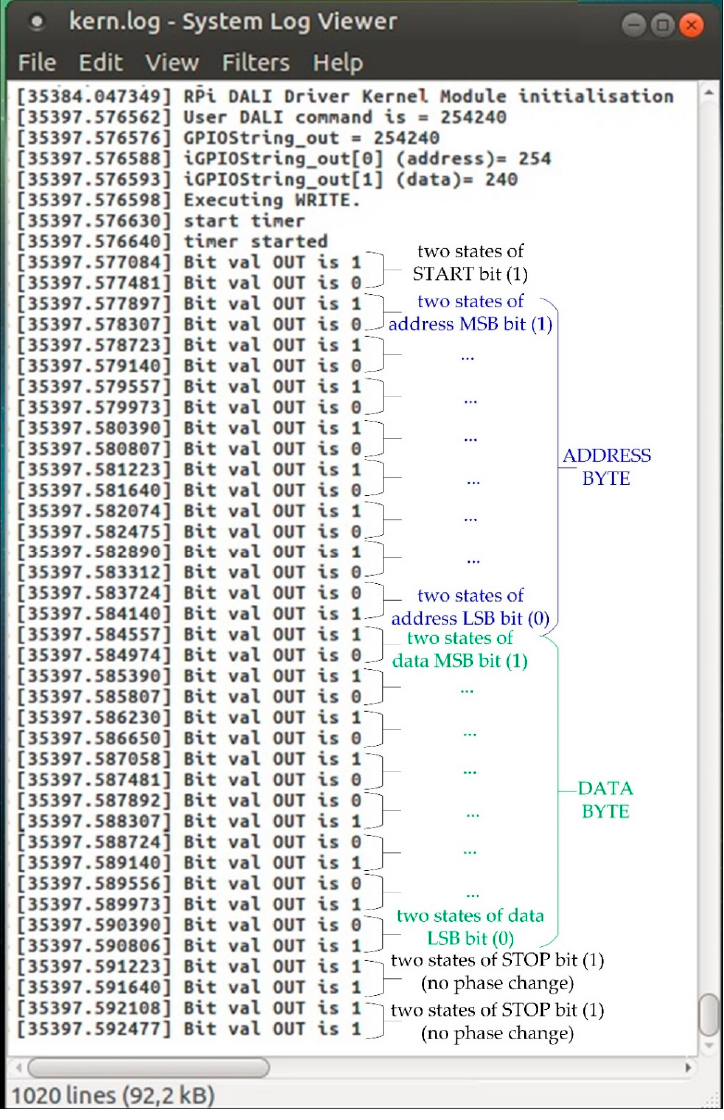
Figure 9. DALI kernel module output execution of a direct arc level command (FEF0).